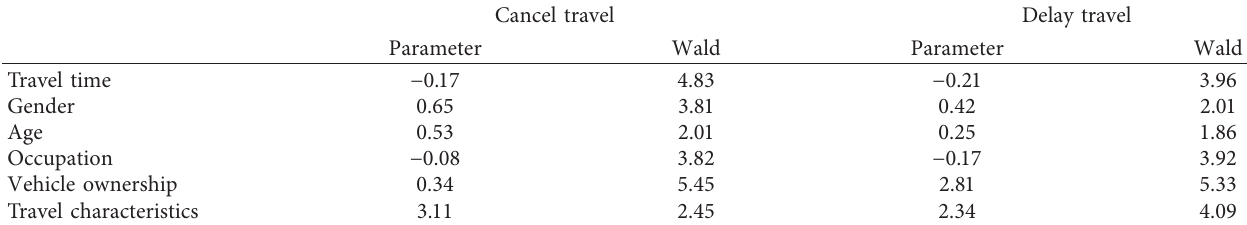
Table 4: Estimation results of characteristic variable parameters of the travel time choice model.